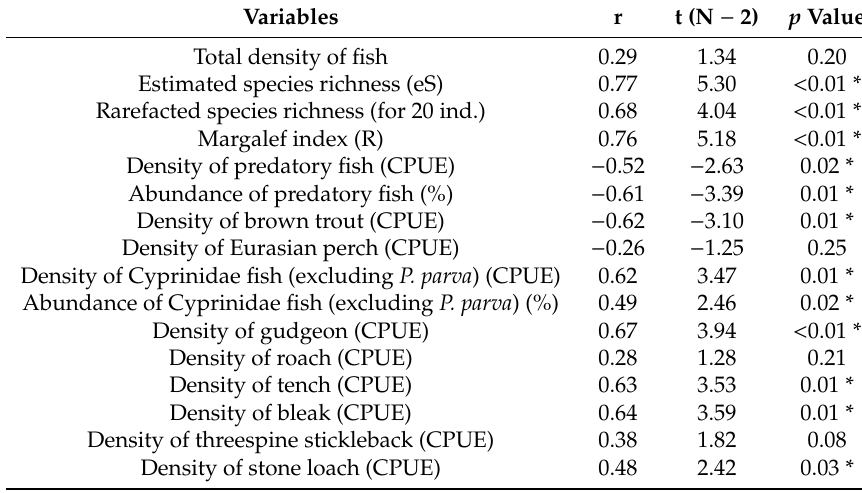
Table 6. Spearman correlations between P. parva density (in catch per unit e ff ort (CPUE)) and selected variables ( n = 21). Variables r t (N − 2) p Value Total density of fish 0.29 1.34 0.20 Estimated species richness (eS) 0.77 5.30 < 0.01 * Rarefacted species richness (for 20 ind.) 0.68 4.04 < 0.01 * Margalef index (R) 0.76 5.18 < 0.01 * Density of predatory fish (CPUE) − 0.52 − 2.63 0.02 * Abundance of predatory fish (%) − 0.61 − 3.39 0.01 * Density of brown trout (CPUE) − 0.62 − 3.10 0.01 * Density of Eurasian perch (CPUE) − 0.26 − 1.25 0.25 Density of Cyprinidae fish (excluding P. parva ) (CPUE) 0.62 3.47 0.01 * Abundance of Cyprinidae fish (excluding P. parva ) (%) 0.49 2.46 0.02 * Density of gudgeon (CPUE) 0.67 3.94 < 0.01 * Density of roach (CPUE) 0.28 1.28 0.21 Density of tench (CPUE) 0.63 Density of bleak (CPUE) 0.64 Density of threespine stickleback (CPUE) 0.38 Density of stone loach (CPUE) 0.48 * correlations significant at p ≤